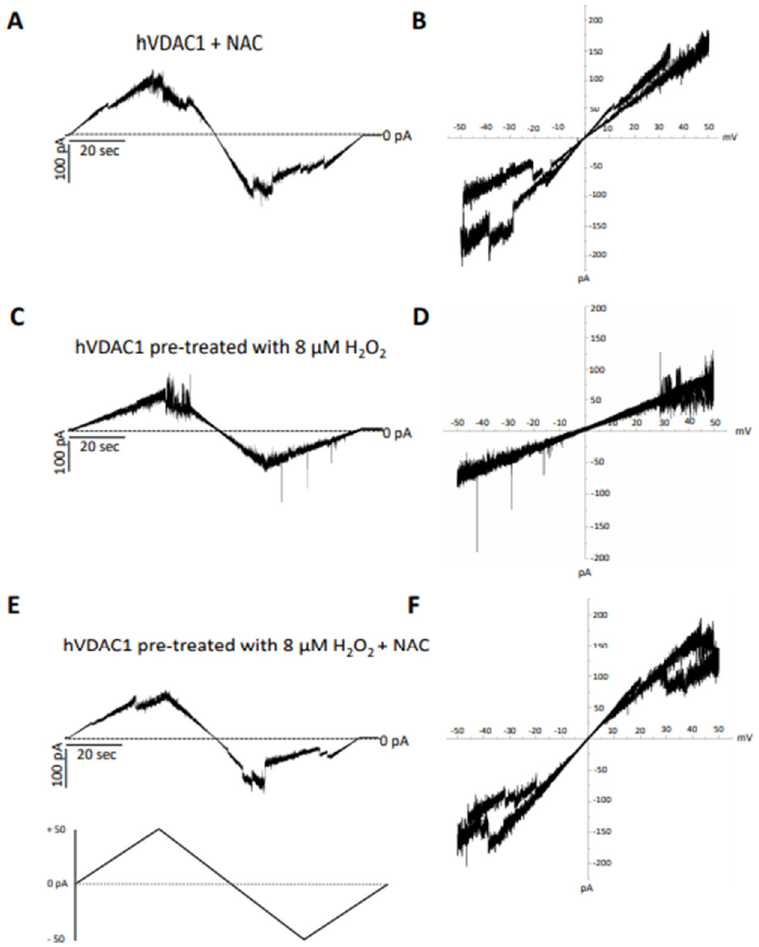
Figure 5. Analysis of the effect of N-acetyl cysteine on hVDAC1 voltage dependence following hydrogen peroxide treatment by triangular voltage ramps. NAC was added at a final concentration of 8 µM to membrane-embedded hVDAC1pA pretreated (panels ( C – F )) or not (panels ( A , B )) with 8 µM H 2 O 2 (panels ( C , D )). Current measurements were performed on symmetrical hVDAC1 pre- treated with 8 µM H 2 O 2 1 M KCl upon application of a triangular voltage ramp of ±50 mV. The corresponding I–V plots were obtained by plotting the current as a function of clamp voltage.